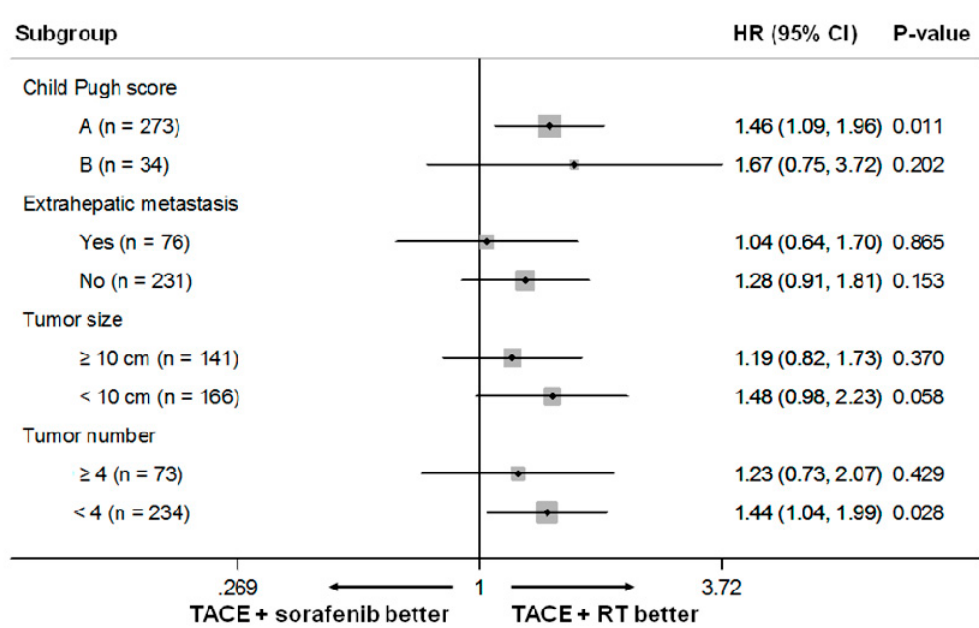
Figure 5. Forest plot of the treatment effect on OS in the subgroup analyses. The size of the squares is proportional to the size of the subgroups. Horizontal lines represent 95% confidence intervals. The position of each square represents the point estimate of the treatment effect. Table 3. Results of Cox proportional hazard models in subgroup without extrahepatic